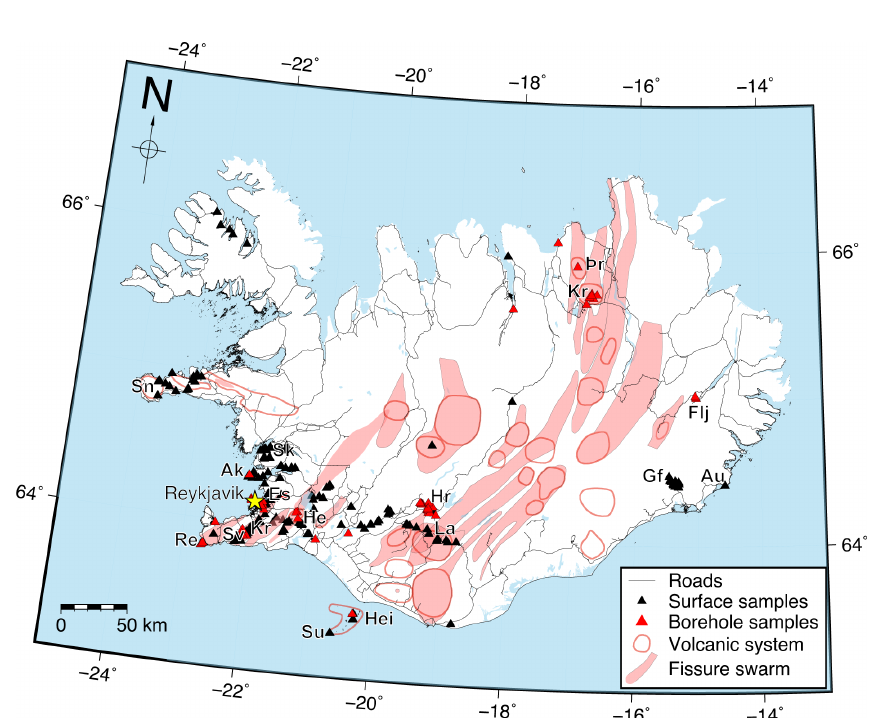
Figure 2. Map of Iceland showing the locations of the surface (black triangles) and borehole (red triangles) samples comprising the database. Volcanic systems are outlined using thick red lines, the associated fissure swarms are highlighted in light red, and roads are shown as thin black lines. The locations mentioned in the text are as follows: Ak – Akranes, Au – Austurhorn, Es – Eja, Flj – Fljótsdalshreppur, Gf